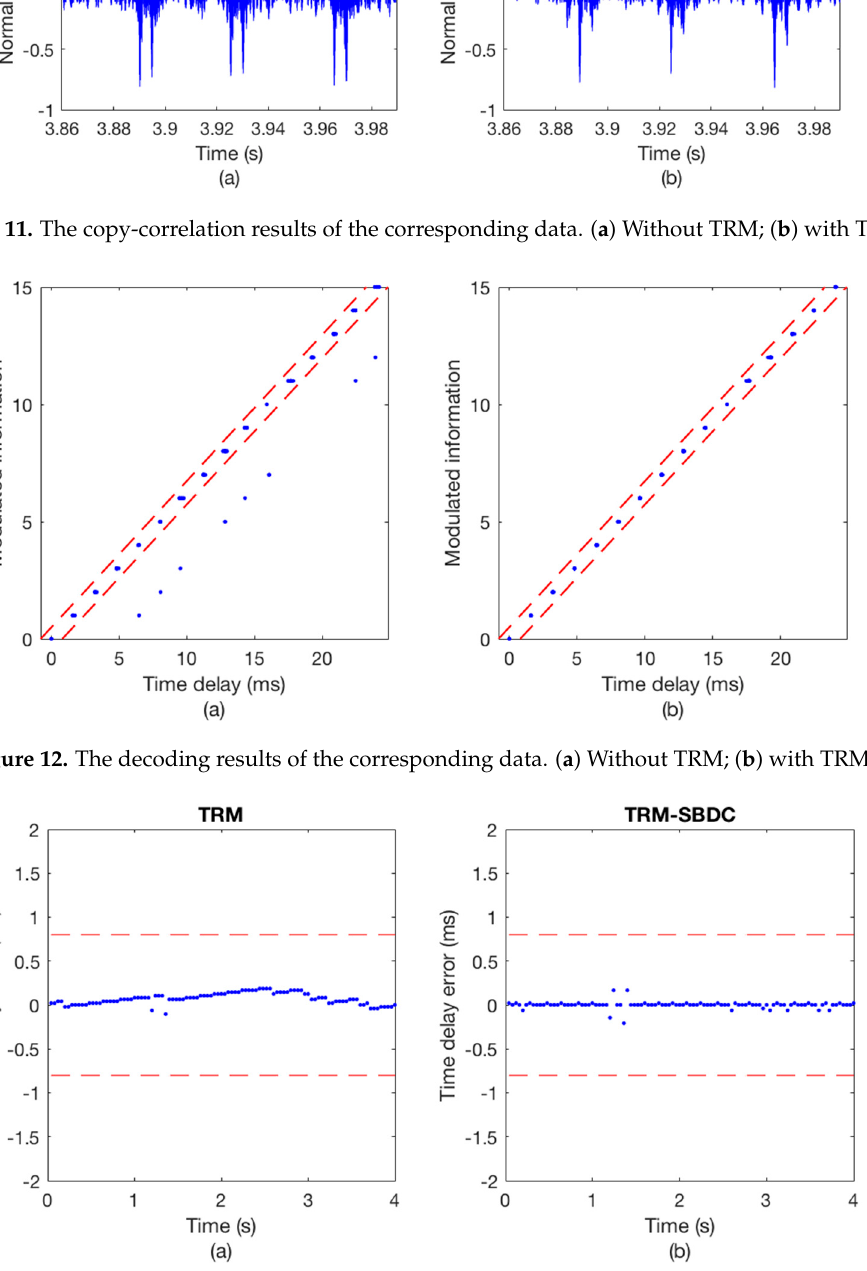
Figure 13. The Doppler time delay error when the sending boat is moored. ( a ) TRM; ( b ) TRM-SBDC.